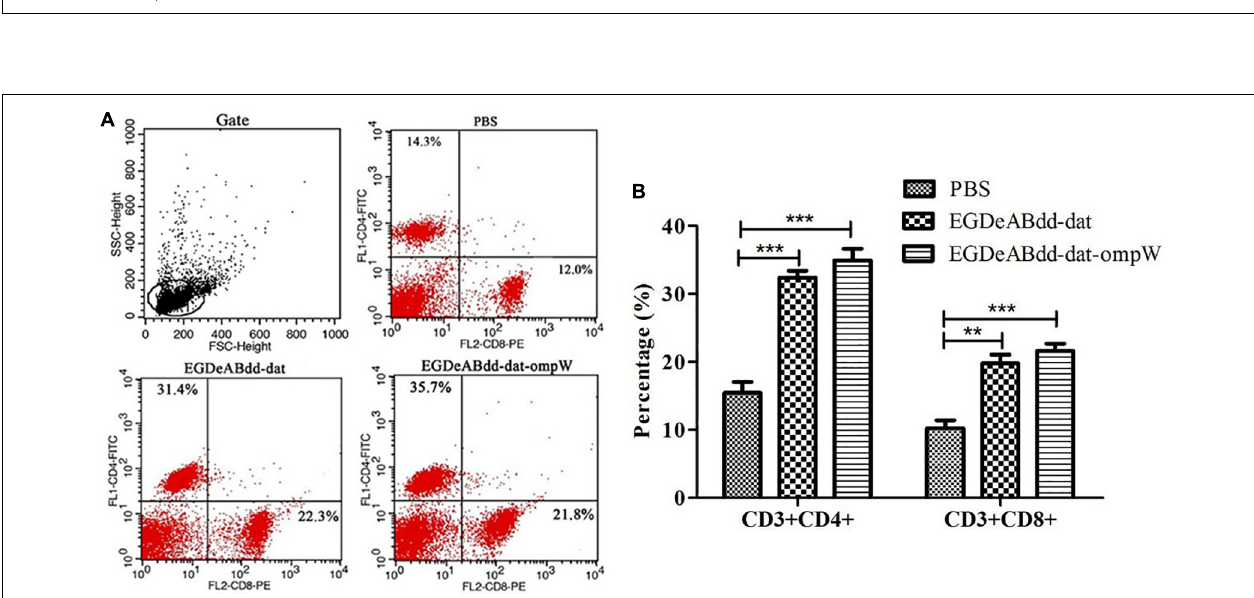
FIGURE 10 | Mouse T-cell immune responses to different bacteria analyzed by flow cytometry. (A) Flow cytometry analysis of splenocyte proliferation. One week after immunization with EGDeABdd-dat and EGDeABdd-dat-ompW for three times using a dose of 5.0 × 10 7 CFUs (0.1 LD 50 ), the splenocytes were collected and stained with CD3, CD4, and CD8 antibodies. (B) The percentage of CD4 + and CD8 + T cells. An increase of T cells appeared in EGDeABdd-dat and EGDeABdd-dat-ompW groups. ** P < 0.01; *** P < 0.001.